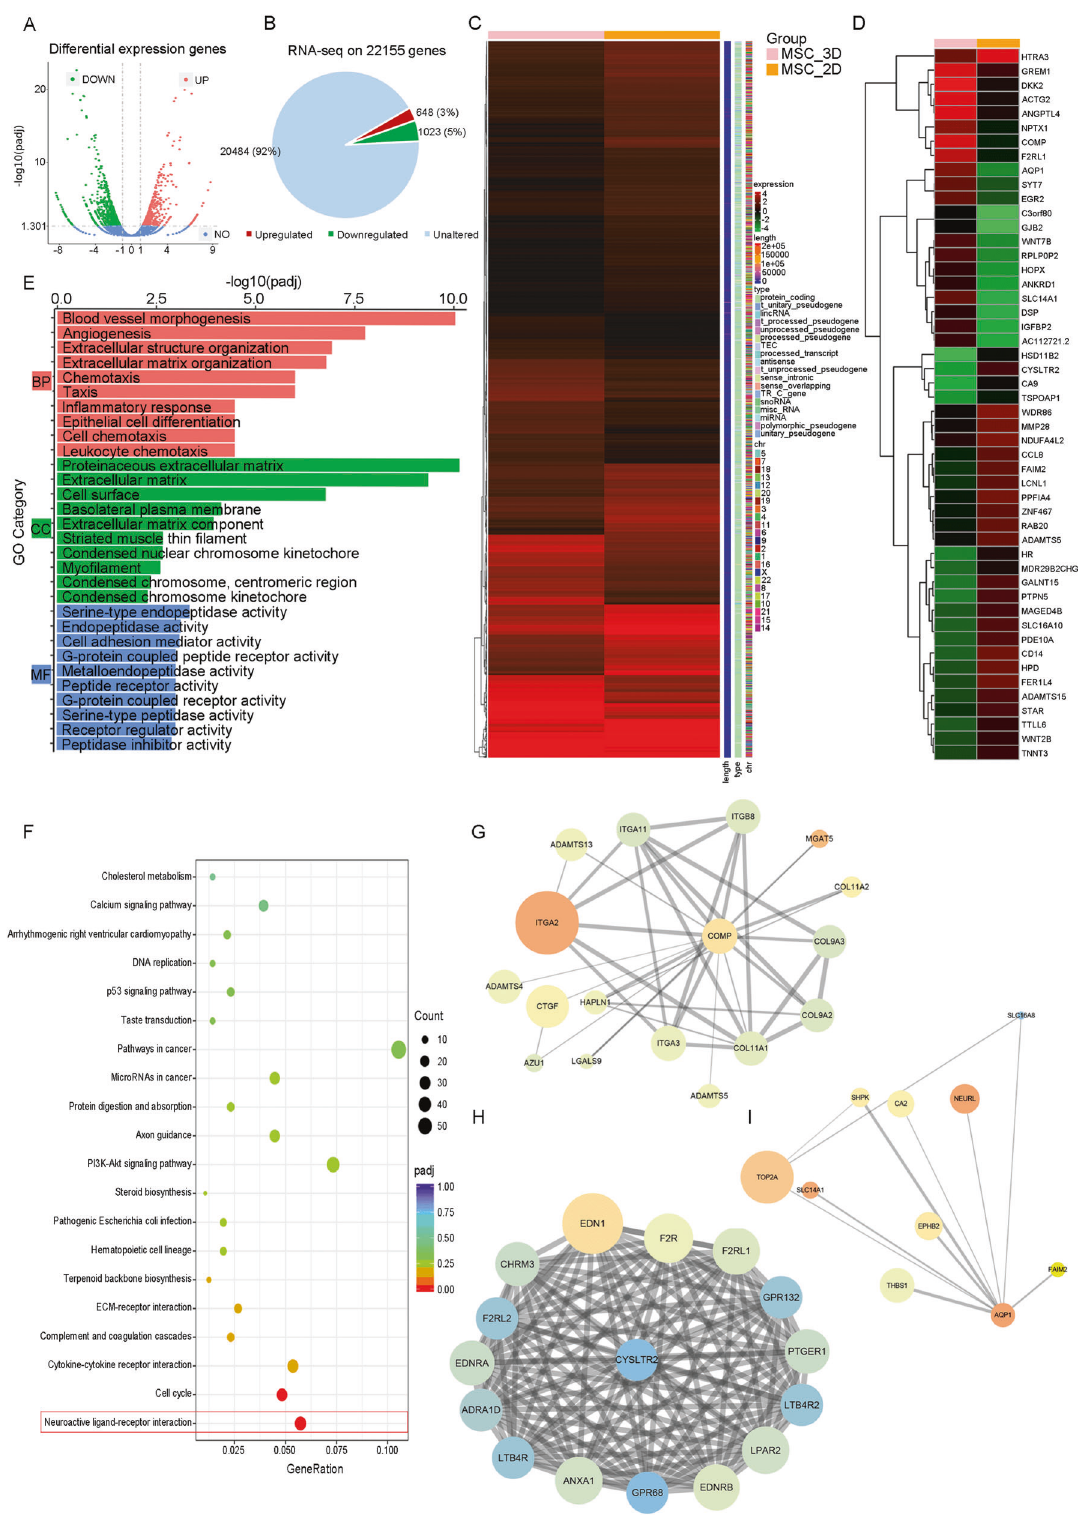
Fig. 6 RNA-Seq analysis of 3D-HPMSCs-modulated genes. A The volcano plot illustrated the differentially expression genes between 3D- and 2D-HPMSCs. Red and green denote the upregulation and downregulation, respectively. B ,Among 22155 genes, 648 genes were upregulated and 1023 genes were downregulated. C , D All of the signi fi cantly differentially expressed genes, and representative top 50 genes after the hierarchical clustering analysis. E The top 10 of most signi fi cantly affected categories in biological process (BP), cellular component (CC) and molecular function (MF) by Gene ontology functional clustering on differentially expressed genes. F The top 20 of most signi fi cantly affected pathway by KEGG pathway analysis of differentially expressed genes. G – I The protein-protein network analysis of representative two upregulated genes COMP, and AQP1, and one downregulated CYSCTR2.